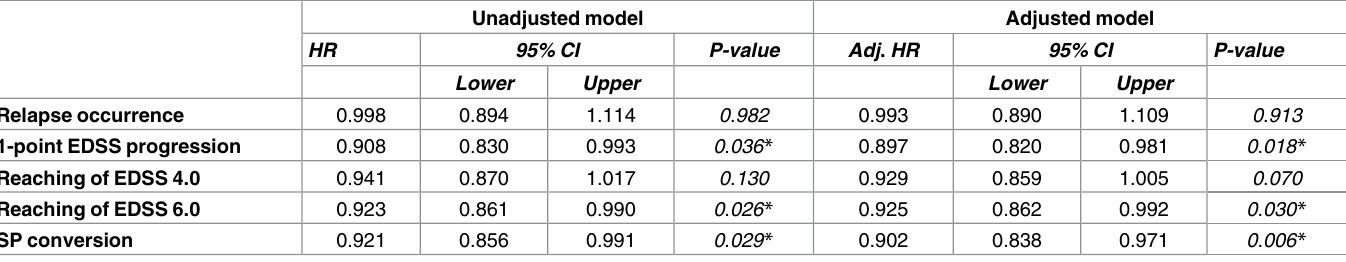
Table 2. Healthcarecosts for MS treatment and the rate of relapse occurrence, of 1-point EDSS progression, of reaching of EDSS 4.0, of reaching of EDSS 6.0, and of SP conversion. Healthcarecosts for DMT administration and management before the specific endpointwas reached(considered as continuous variables), have been associated with the rate of relapse occurrence, of 1-point disabilityprogression,of reachingof EDSS 4.0, of reachingof EDSS 6.0, and of SP conversionduringthe follow-upperiod. P-values, hazardratios (HR), and 95% confidenceintervals (95%CI) are shownfrom time varying Cox regressionmodels, subsequently adjustedfor age, gender, diseaseduration, and